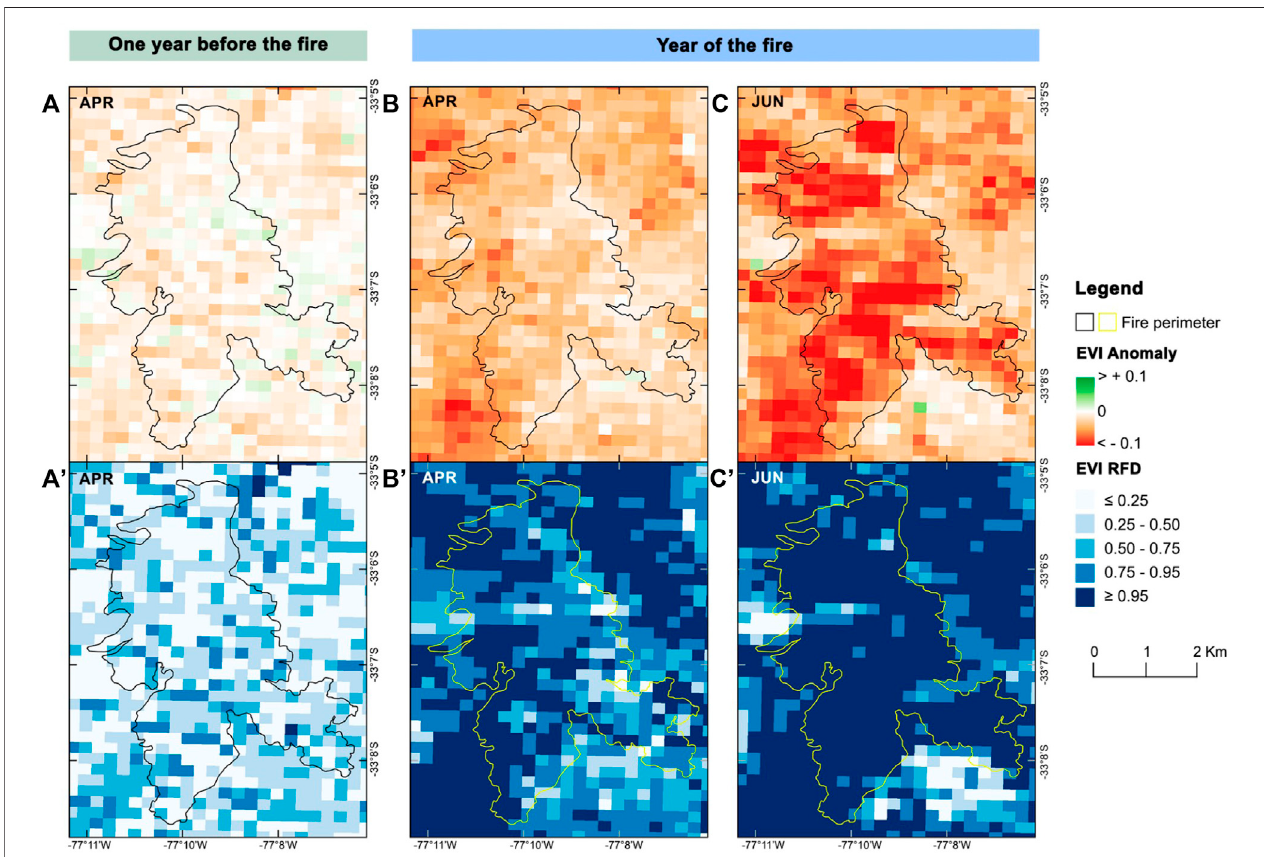
FIGURE 4 | Spatial distribution of EVI anomalies (A – C) and their position within the reference frequency distribution (RFD) (A ’– C ’ ) based on the 2000 – 2018 historical records for three moments in time: 1 year before the fi re (April 2019, left panels), a month before the fi re (April 2020, center panels) and a month after the fi re (June 2020, right panels). Dark blue areas show areas where EVI anomalies were extreme, being outside the 0.95 of the historical RFD records (2000 – 2018).